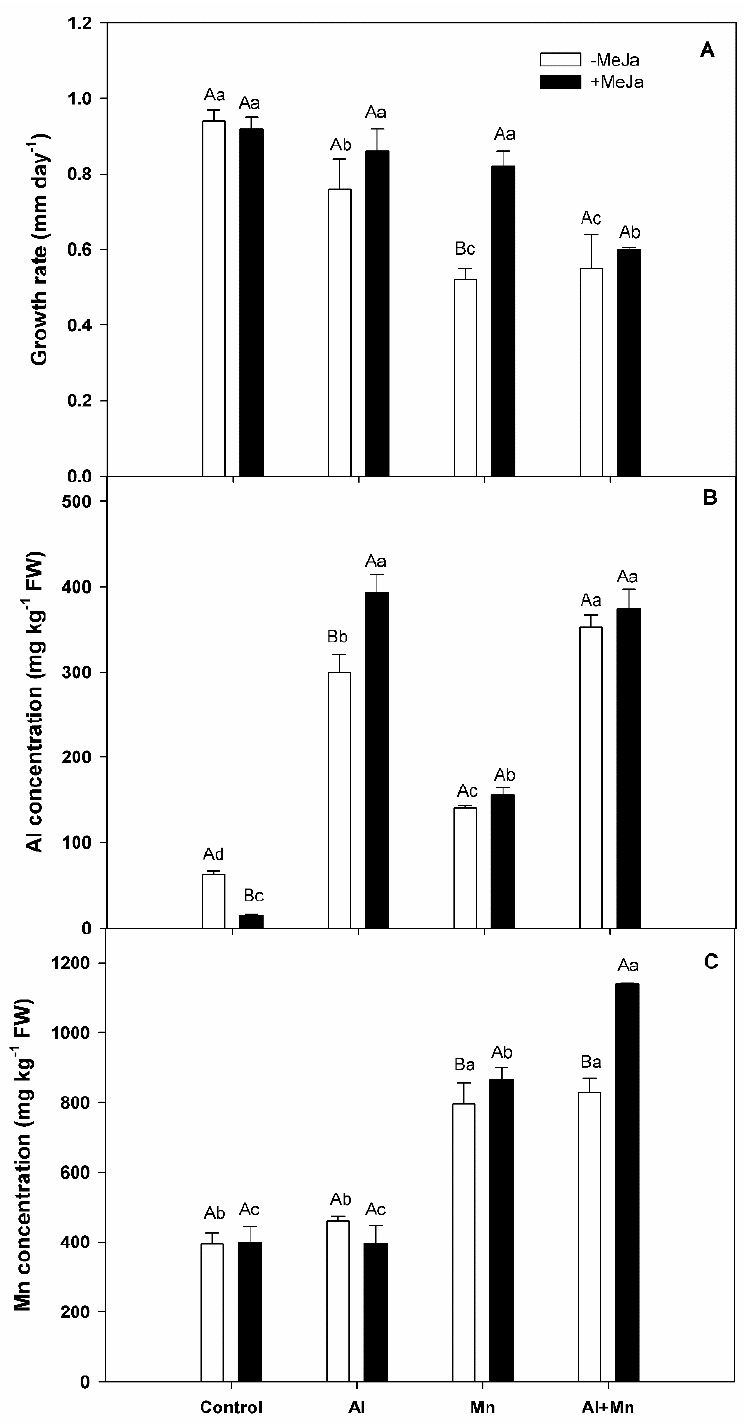
Figure 1. ( A ) Growth rate, ( B ) Al concentration, and ( C ) Mn concentration in leaves of highbush blueberry cv. Legacy plants subjected to different soil treatments (Al, Mn, and Al–Mn toxicity), and exogenous MeJA application. All values represent averages of ten biological replicates ± SE. Different upper-case letters indicate significant differences between MeJA treatments for the same soil conditions according to Tukey’s test ( p ≤ 0.01). Different lower-case letters indicate significant differences among soil conditions for the same MeJA treatment according to Tukey’s test ( p ≤ 0.01).